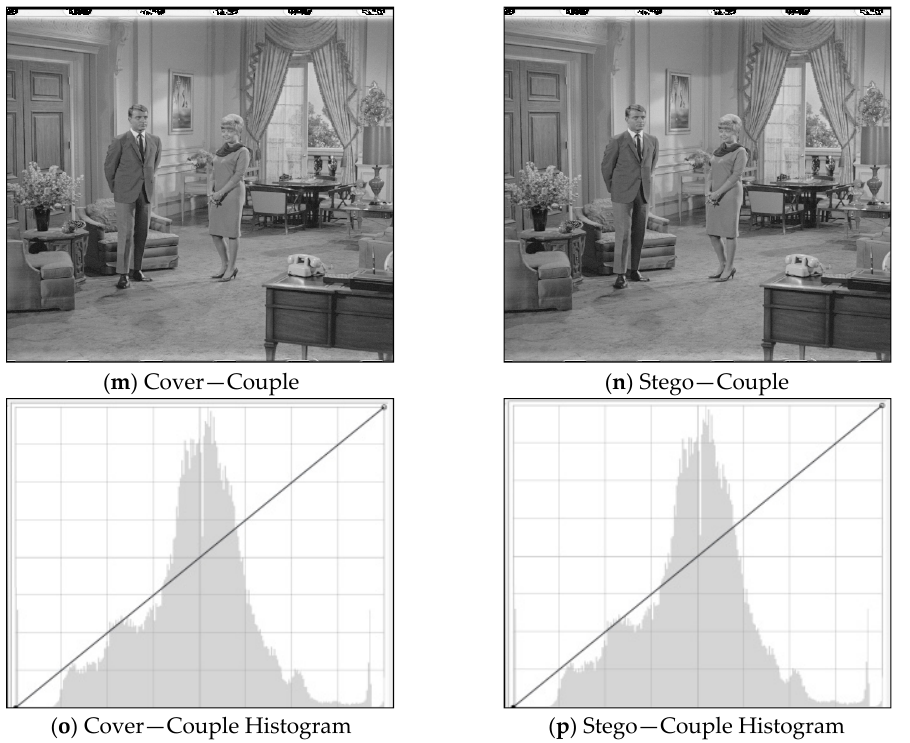
Figure 6. Comparison of histograms for images from USC-SIPI [24] dataset. The figures are ( a ) Aerial, ( e ) Airplane, ( i ) Boat, and ( m ) Couple.